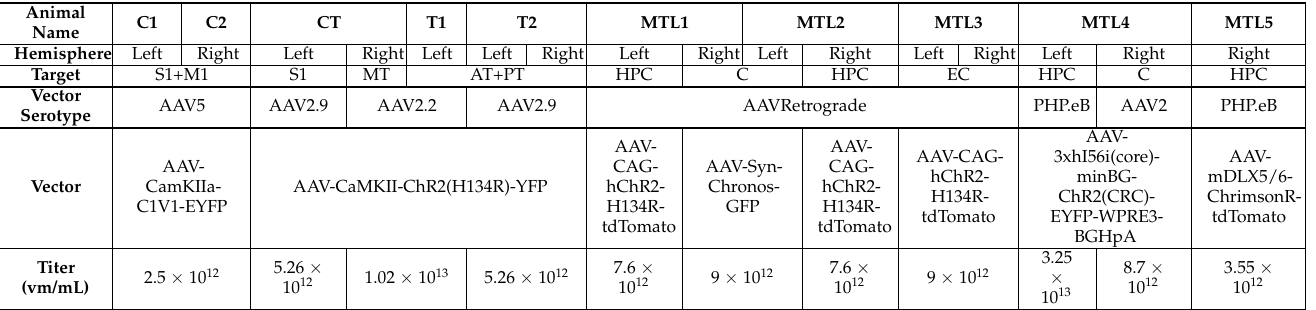
Table 2. Virus information. S1 (primary sensorimotor cortex), M1 (primary motor cortex), AT (anterior thalamus), MT (medial thalamus), PT (posterior thalamus), HPC (hippocampus), C (tail of